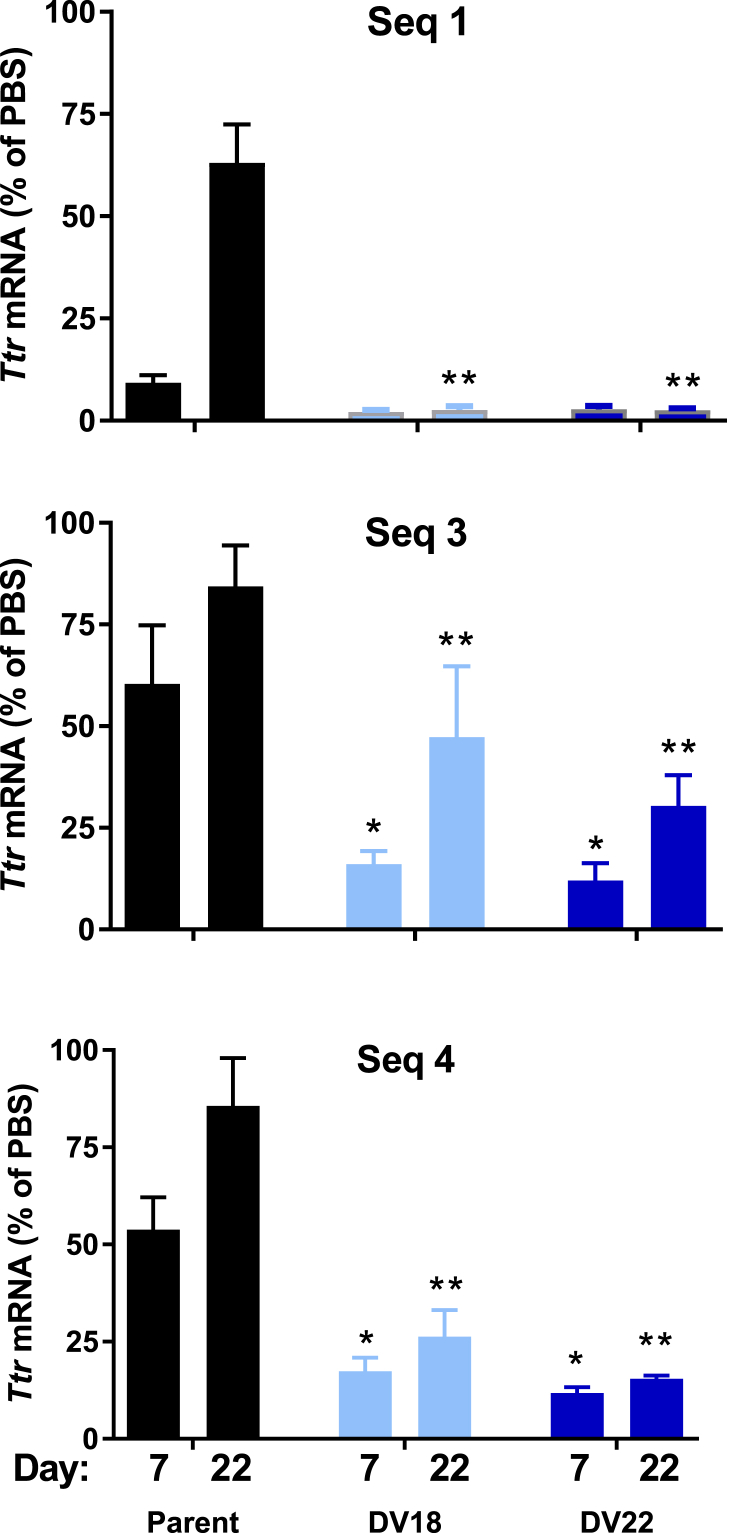
Application of Advanced Designs DV 18 and DV 22 to Multiple SequencesIn vivo activity and duration of optimized DVs compared to parent designs post single 3 mg/kg s.c. administration of conjugates in mice (n = 3 per group and time point). Ttr expression was assessed in liver at 7 and 22 days post-dose. Data are presented as average percent of PBS-treated animals. Data were analyzed by two-way ANOVA, followed by Dunnett’s post-test for multiple comparisons. Results of post-test indicated as a single asterisk for significant compared to parent at day 7 and double asterisk for significant compared to parent at day 22. Error is represented as the SD.